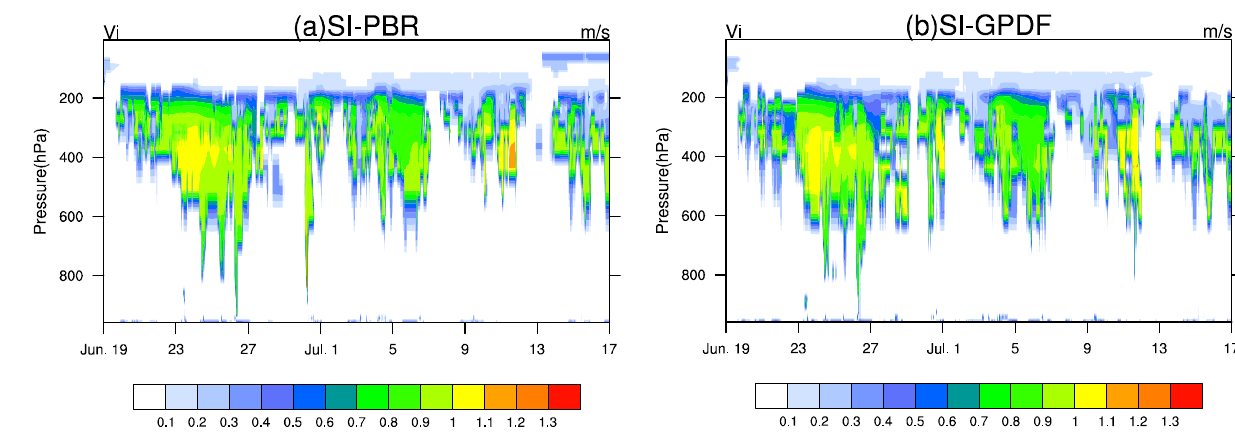
Figure 7. Temporal-vertical plot of mass-weighted ice falling speed in ( a ) the SI-PBR and ( b ) the SI-GPDF.